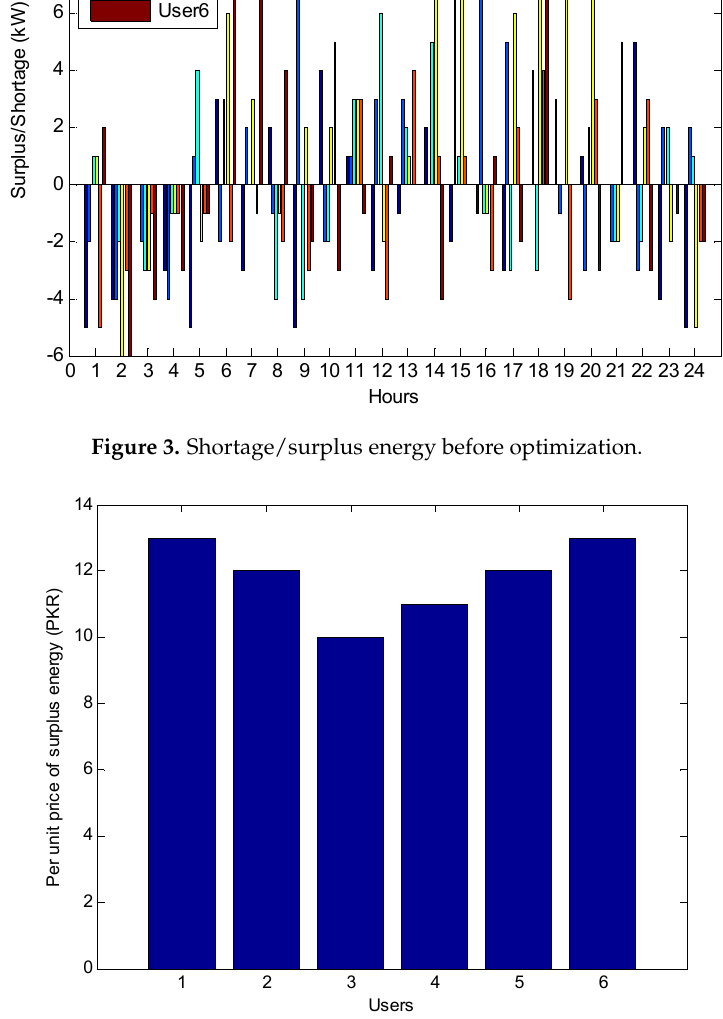
Figure 4. Price of selling surplus energy in Pakistani Rupees (PKR).